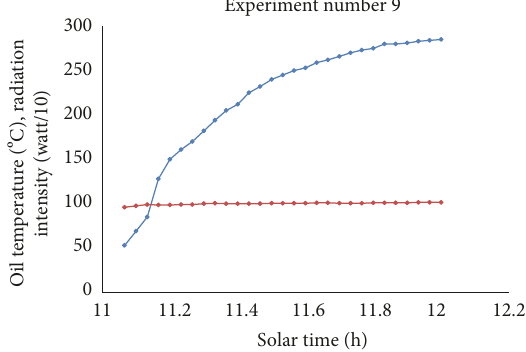
Figure 16: Plot of temperature (blue) and solar radiation intensity (red) versus time for the third experiment with 850gm of vegetable oil load. Radiation intensity is divided by 10 to fi t the